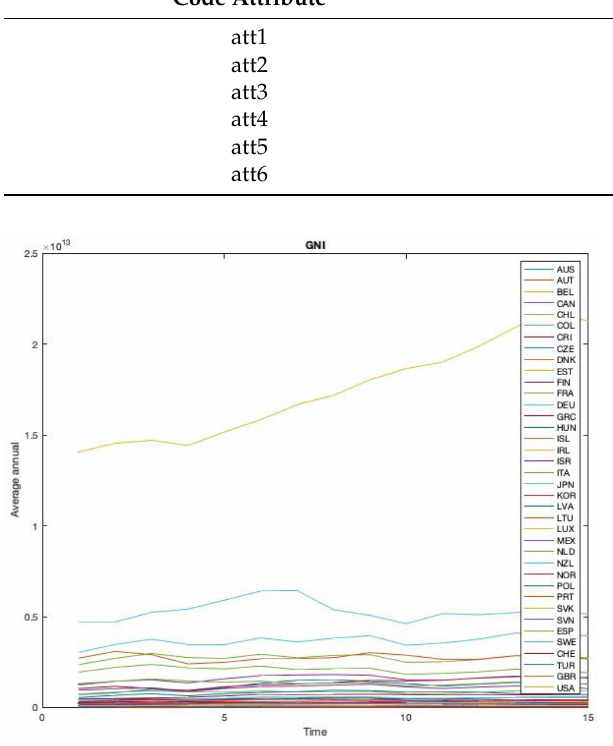
Figure 2. OECD members: average annual GNI.